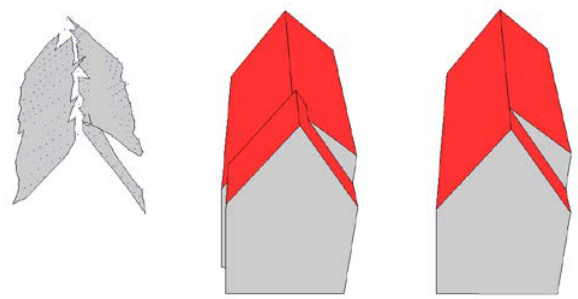
Figure 6. The segments of two adjacent gable roofs overlaid with surface points (left), the reconstructed building after local (middle) and after global half-space adjustment (right).